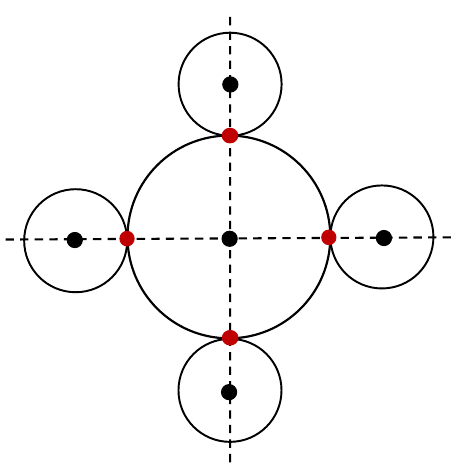
Figure 10 . Clover diagram for ‘=C (cid:29) 1, (cid:28) < (cid:12)= 4 and n = 4. Dashed lines separate replicas and the dots indicate the local horizons of each part of the